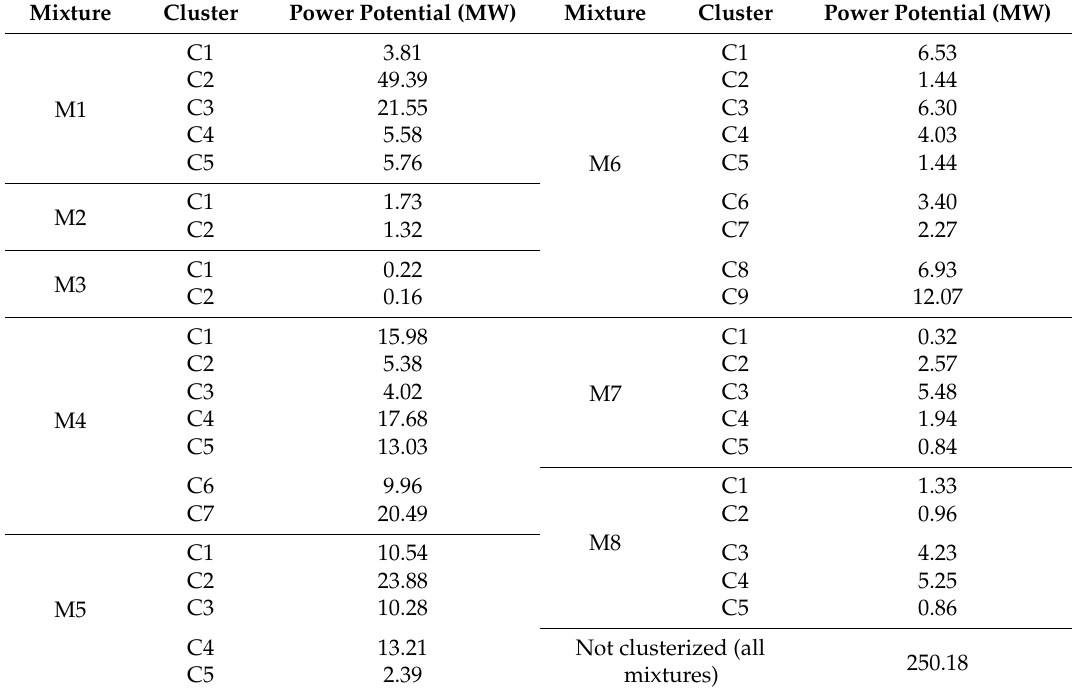
Table 7. Nominal characteristics of the selected facilities.